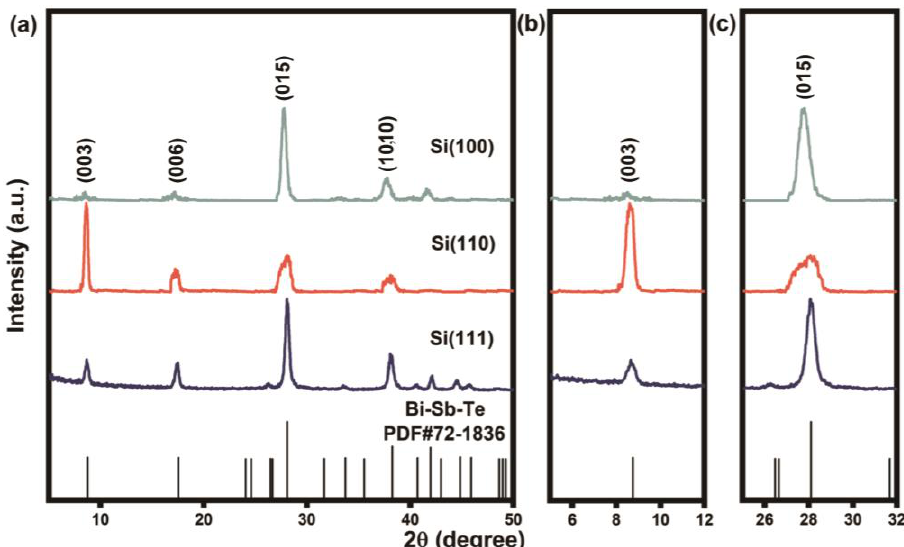
Figure 2. ( a ) XRD patterns of Bi-Sb-Te films deposited on Si(100), Si(110) and Si(111) substrates. ( b ) and ( c ) Extended view of (003) and (015) peaks.